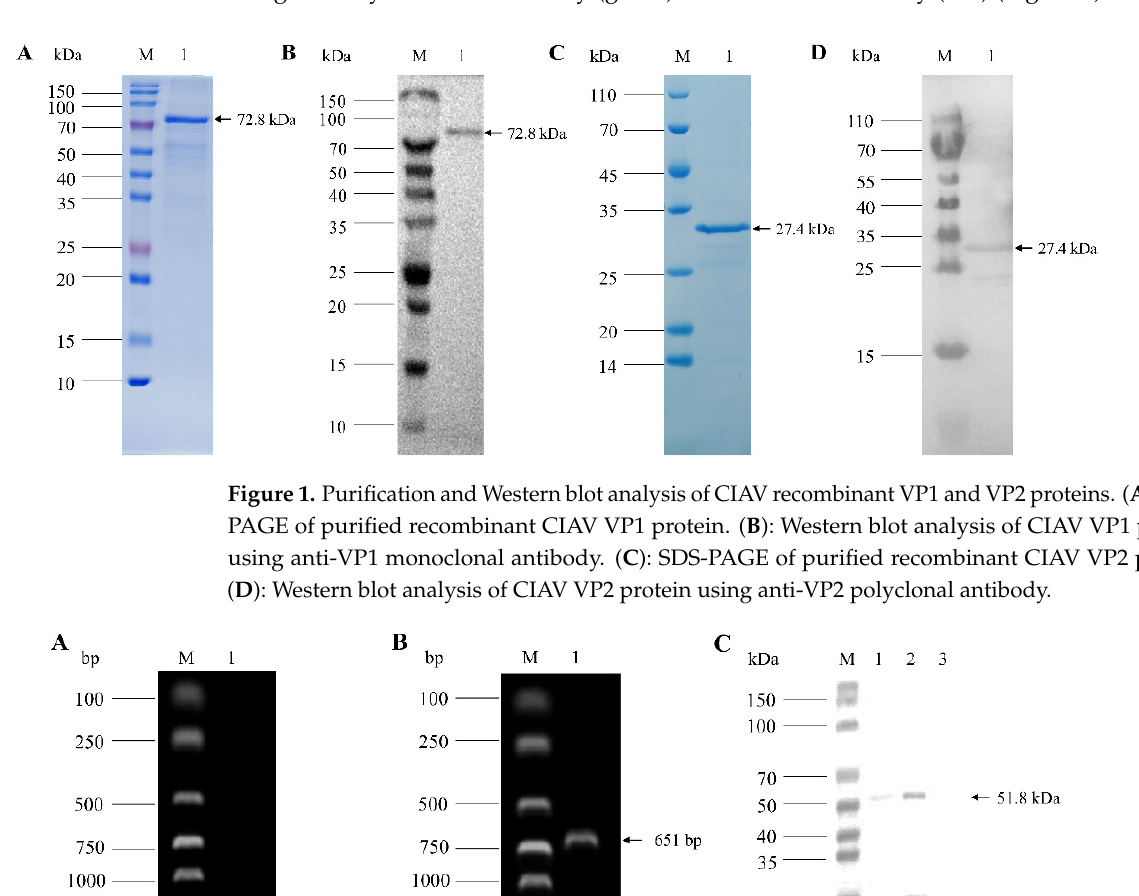
Figure 1. Purification and Western blot analysis of CIAV recombinant VP1 and VP2 proteins. ( A ): SDS-PAGE of purified recombinant CIAV VP1 protein. ( B ): Western blot analysis of CIAV VP1 pro- tein using anti-VP1 monoclonal antibody. ( C ): SDS-PAGE of purified recombinant CIAV VP2 pro- tein. ( D ): Western blot analysis of CIAV VP2 protein using anti-VP2 polyclonal antibody.